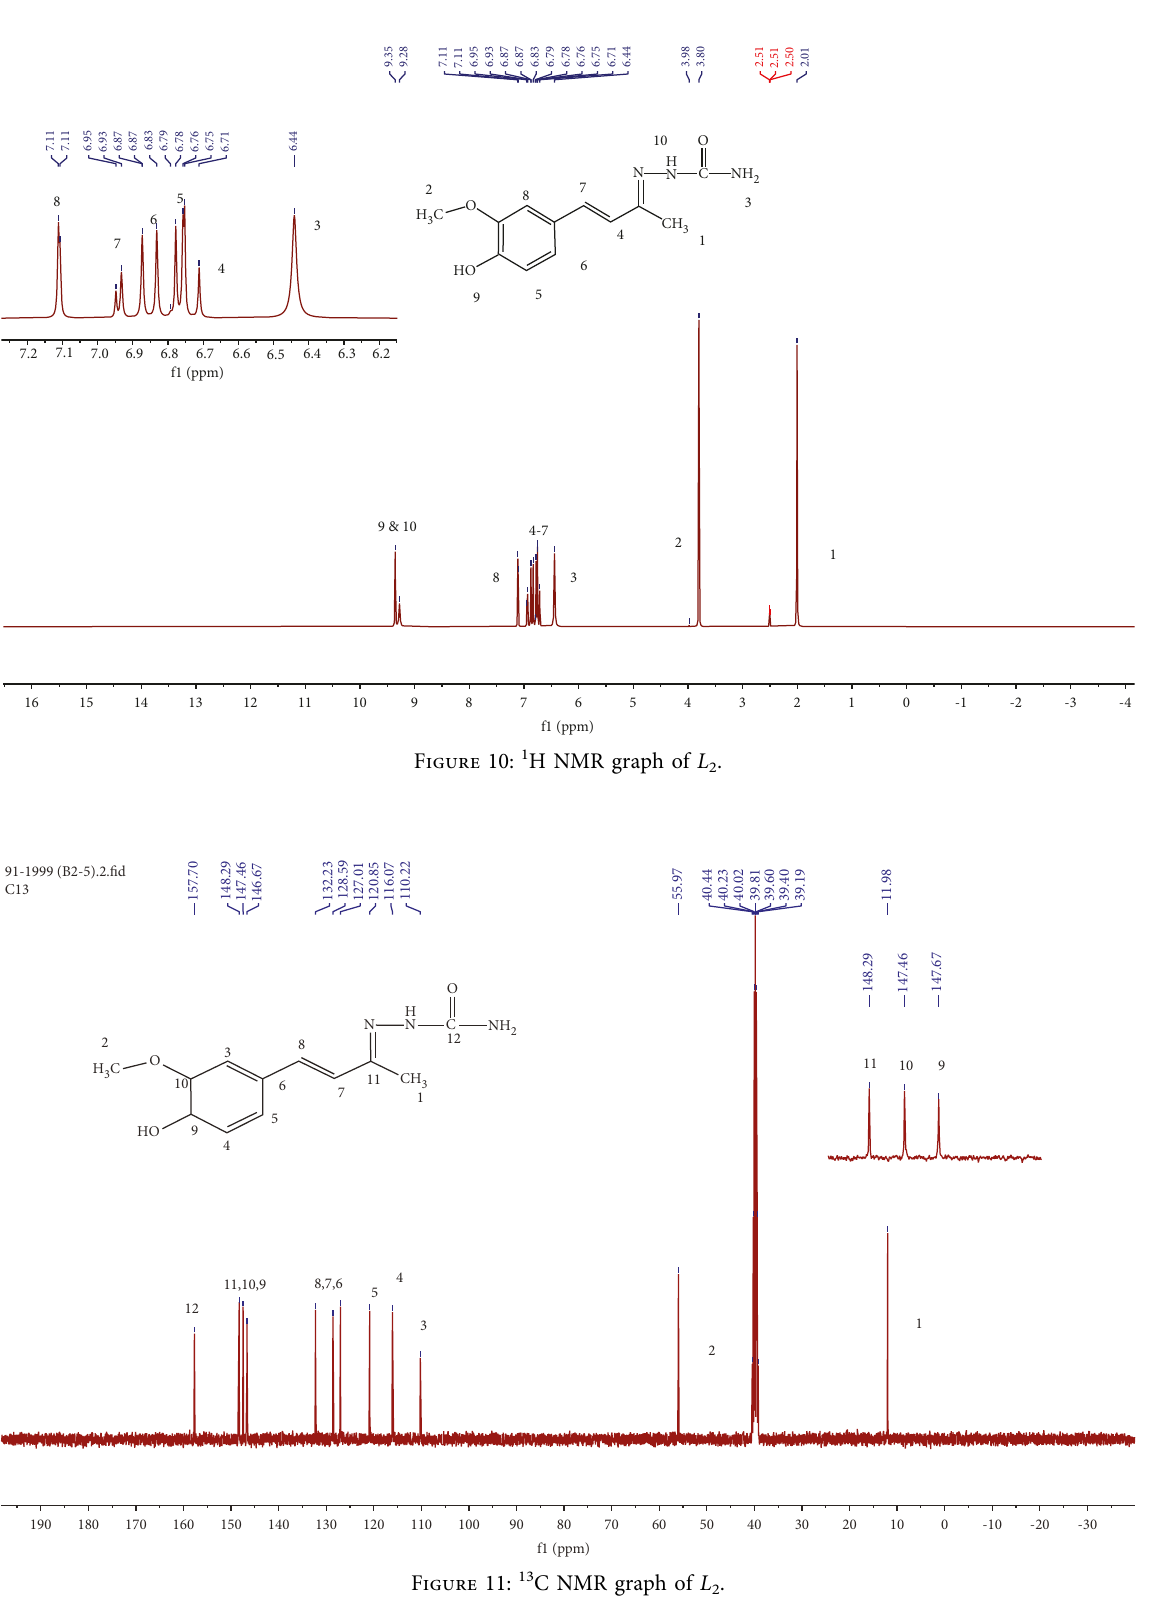
Figure 11: 13 C NMR graph of L 2 (Table 5). The antiradical potential results were best cor- related with the sample compounds that had good docking marks. As a result, the compounds could be useful as